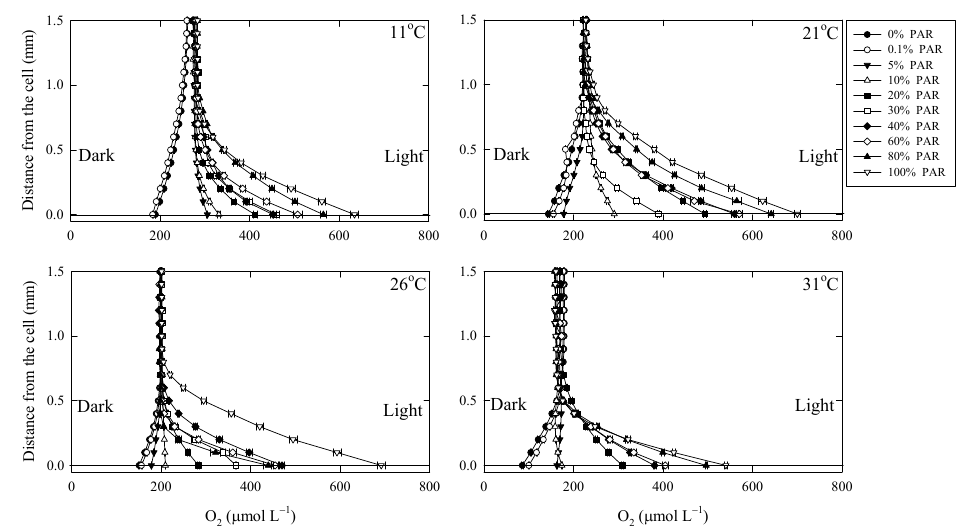
Figure 3. O 2 variation with irradiance at each temperature (11°C, 21°C, 26°C, and 31°C). The error bars represent the standard error in triplicate reading of O 2 microsensor. 3.2. Effects of Irradiance and Temperature on Respiration and Photosynthesis The relationships between O 2 production and irradiance (P–I curve) at each tem- perature are shown in Figure 4 and Table 1. The P(E) values at 11–21°C reached asymp- totic values at >500 μmol photon m –2 s –1 , but gradually increased at higher temperatures (>21°C). The maximum P(E) ranged from 4.01 ± 0.23 to 14.1 ± 1.16 mmol m –2 d –1 , and varied with increasing water temperature.